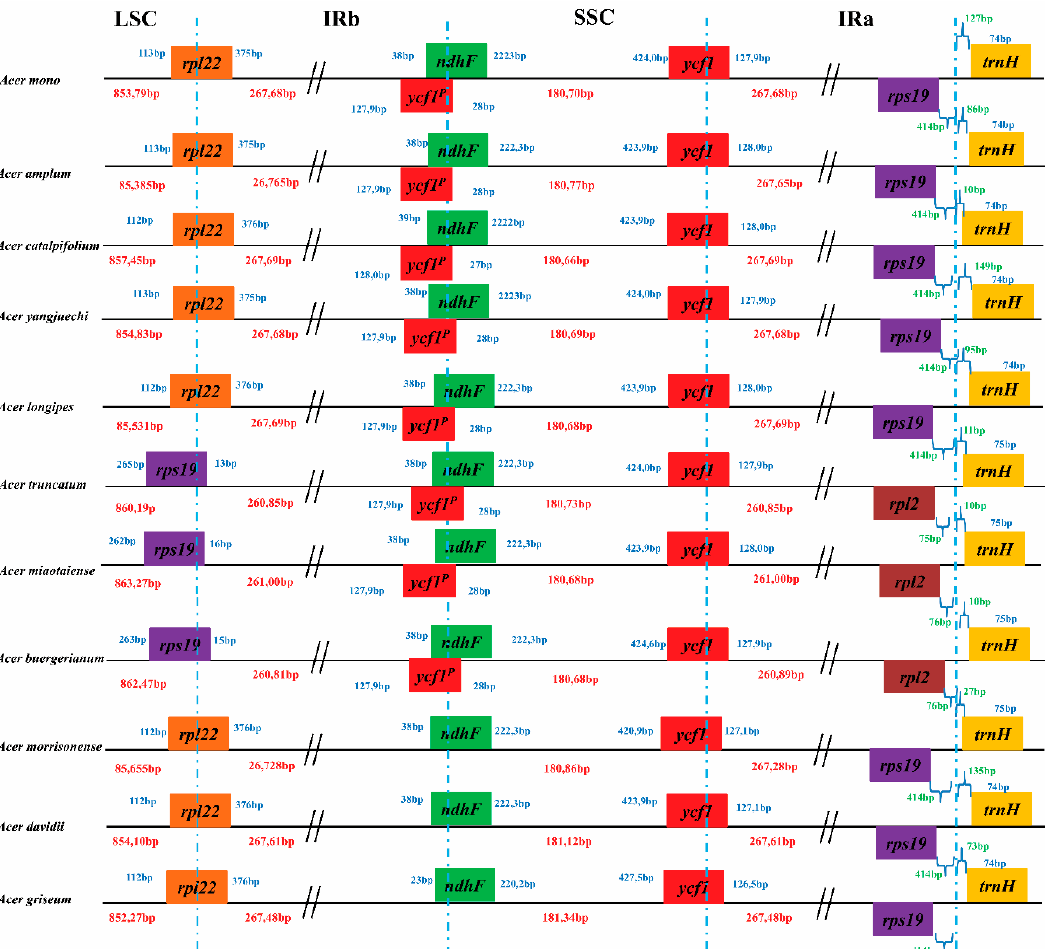
Figure 2. Comparison of the junction sites of the LSC, IRs and SSC regions among 13 Acer sect. Platanoidea species chloroplast genomes. Di ff erent colour boxes indicate specific genes and those above the genome lines indicate their transcriptions in a forward direction, while the under-line boxes are in the reverse direction. The length of the LSC, SSC, and IR regions is shown in red, the length of the gene distance from the boundary is shown in green, the length of the gene is shown in blue, and the P represents the